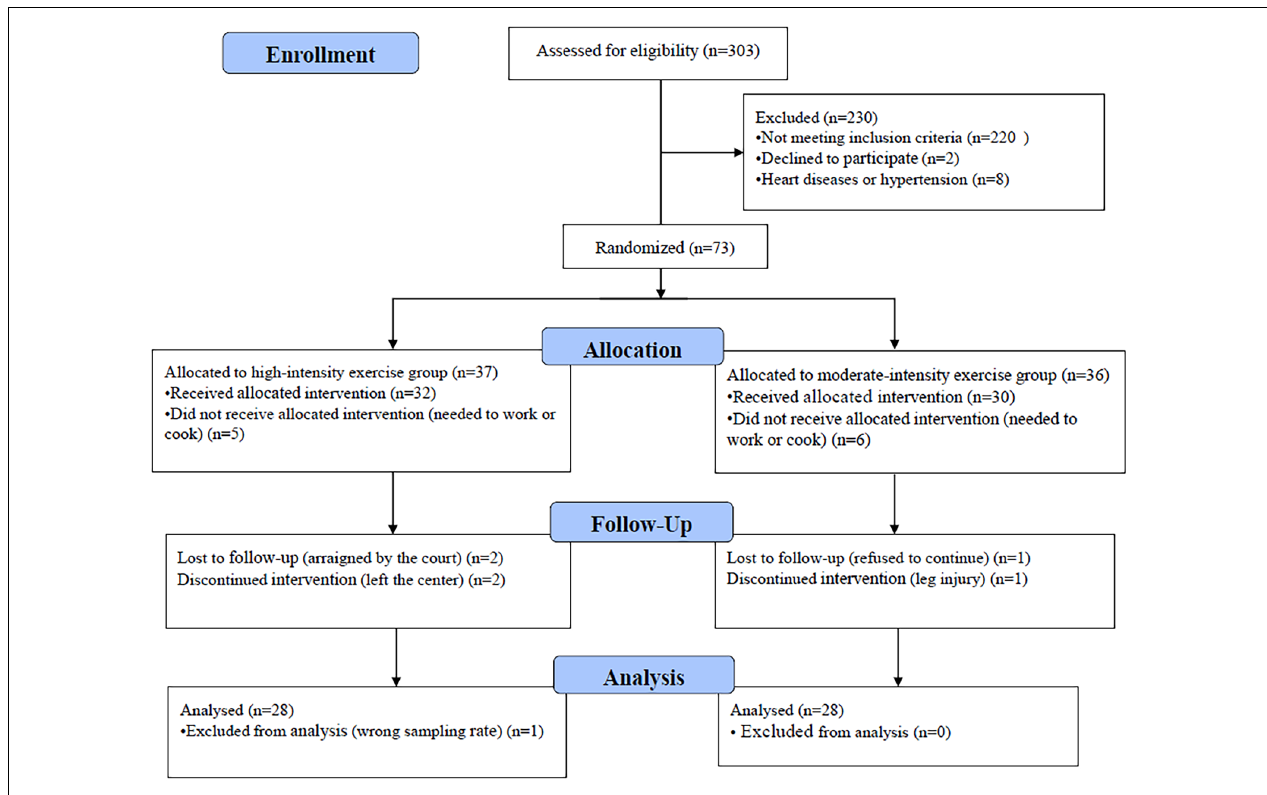
FIGURE 1 | Flowchart of participant enrollment.